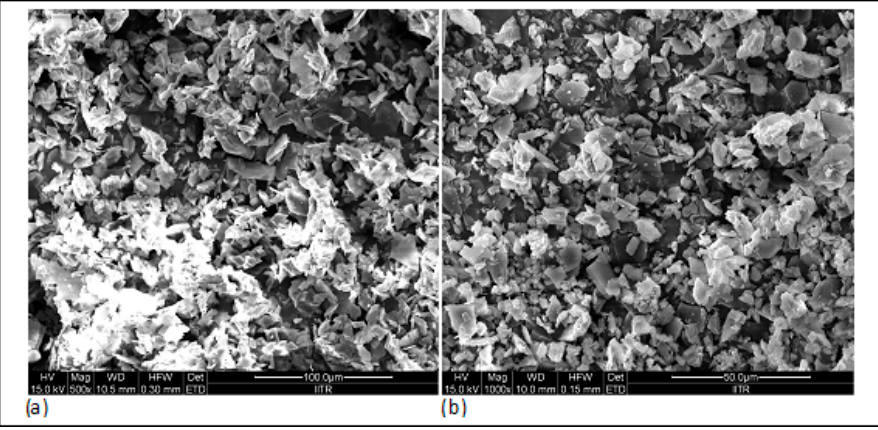
Figure 8. Field emission scanning electron microscopy: ( a ) plain NS and ( b ) BONS4.